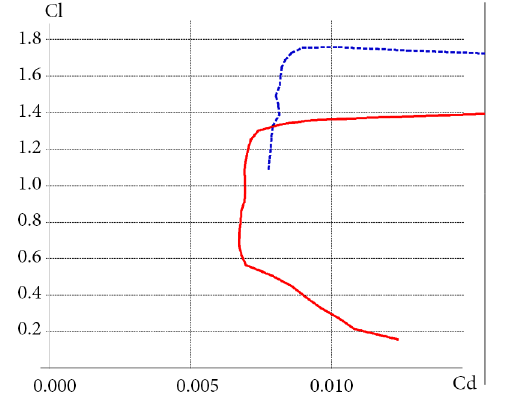
Fig. 5. Polar curves of airfoil LAP 7-131/17 with flaps at +15 deg and without the VGMF (Figure: P. Lauk)